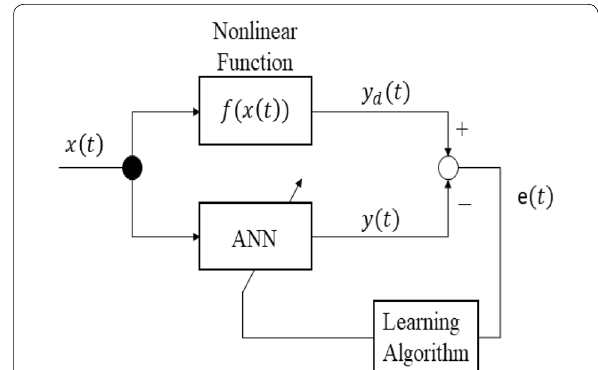
Fig. 2 Back propagation neural network with a nonlinear function.